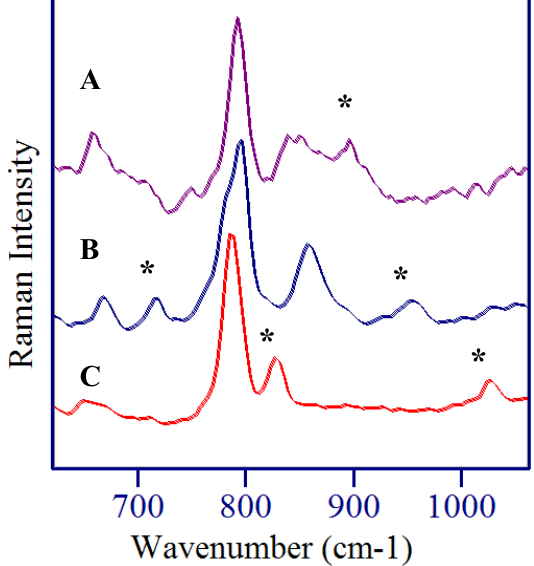
Figure 6. SERS spectra of A) 5-fluoro-2’-deoxyruidine, B) 5-fluorouridine, and C) 5- fluorouracil. Unique peaks identified by * . Conditions as in Figures